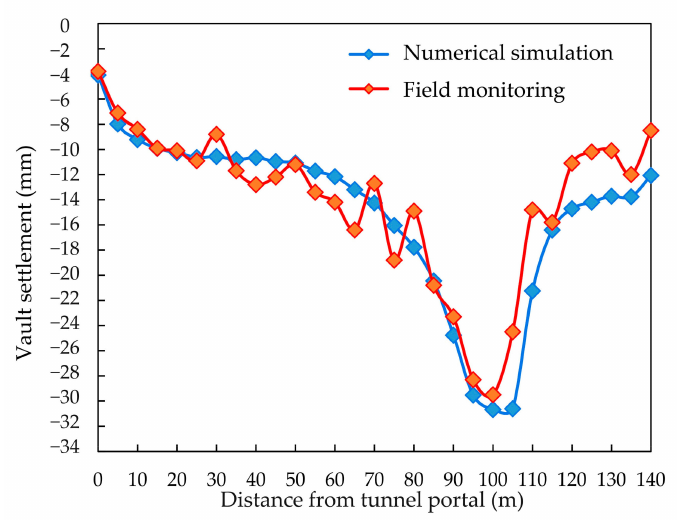
Figure 6. Vertical settlement of the vault of the right